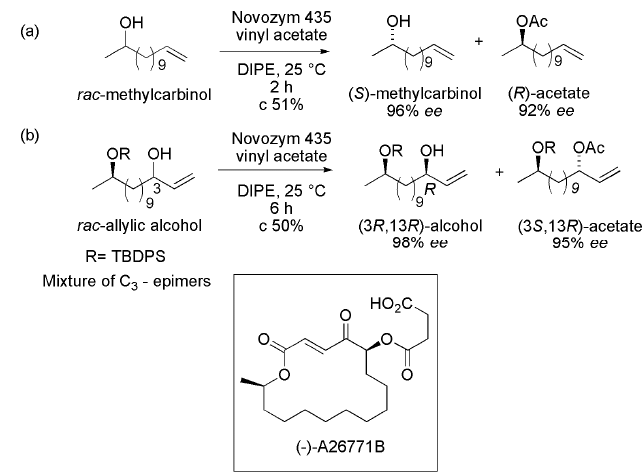
Scheme 33. Kinetic enzymatic acylation of the ( a ) racemic tridec-12-en-2-ol and ( b ) allylic